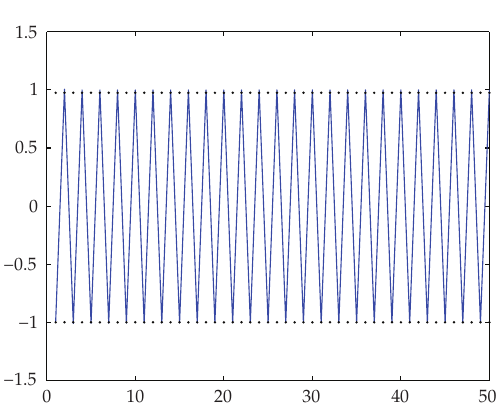
Figure 1: Plot of (cid:4) 3.13 (cid:5) and its bounds given by (cid:4) 3.14 (cid:5)